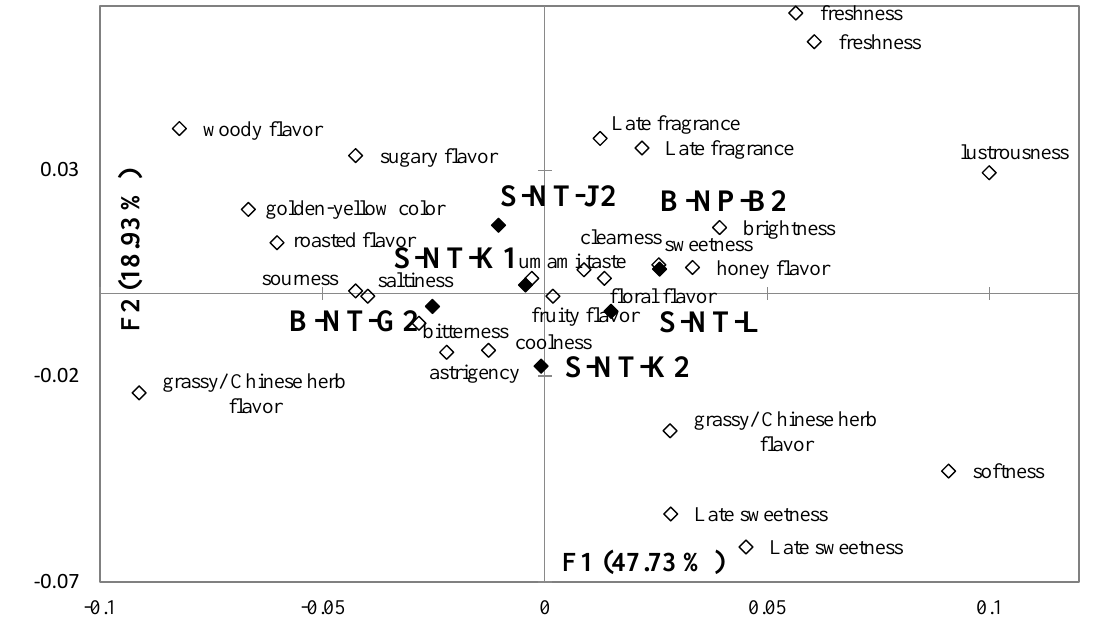
Figure 5. A bi-plot by correspondence analysis for the cold infusions of the second round of Taiwanese GABA Oolong tea made by the TTES #12 in association with the 24 sensory attributes selected by more than 20% of participants. Significant difference ( p < 0.05) of panelists’ selection proportions for each attribute among the seven tea samples were determined by Cochran’s Q test. The pairwise post-hoc McNemar test (Bonferroni) was also performed, and the tea samples signed with different alphabet letters were significantly different in the frequencies of panelists’ selection for the attribute listed in the same row.